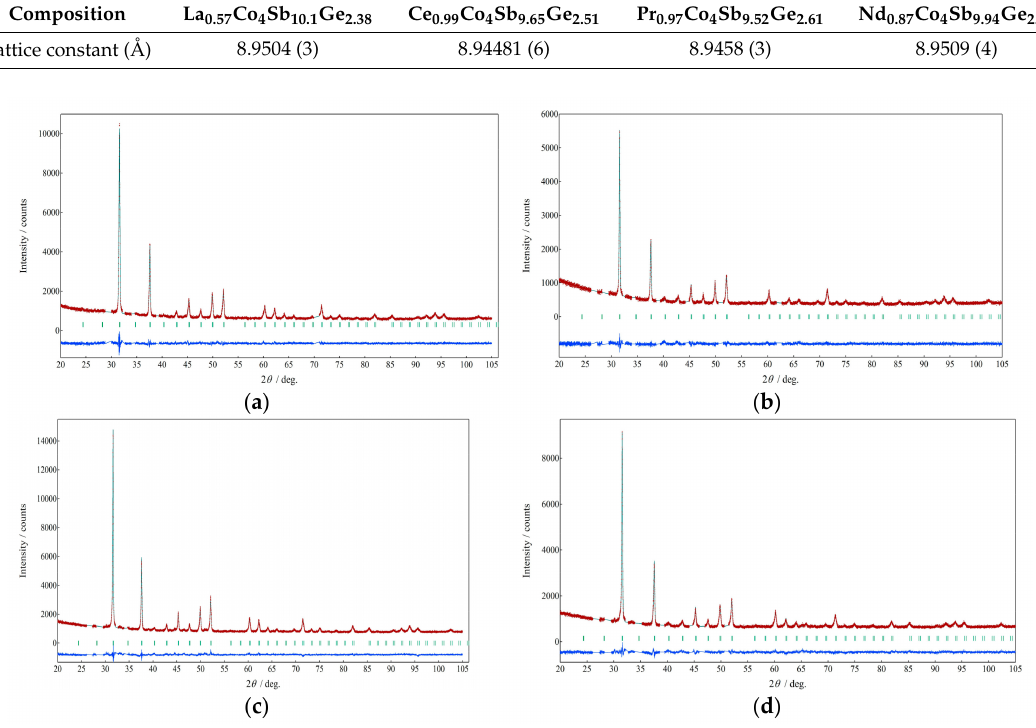
Table 1. Lattice constant and chemical composition of Ge-substituted skutterudite compounds.